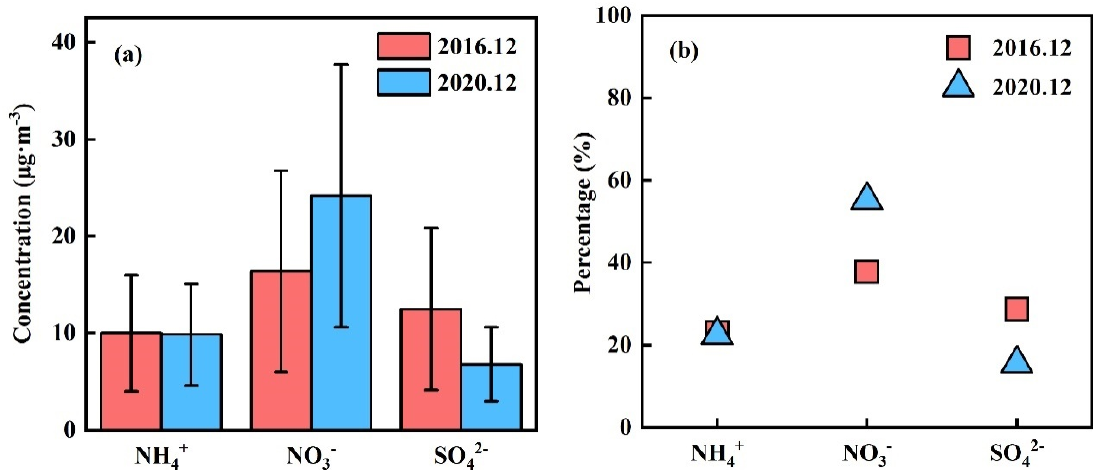
Figure 4. Comparison of water-soluble ions between December 2016 and 2020. ( a ) Comparison of SNA mass concentration in December 2016 and December 2020, ( b ) proportions of SNA in December of different